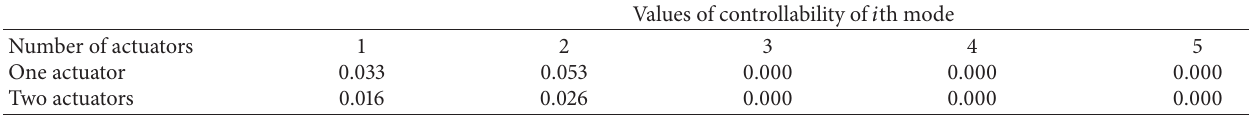
Figure 6: Frequency response of the plate controlled by the piezoelectric actuator-sensor. The first three modes are the controlled modes, while the next two modes are the residual modes: (a) one actuator-sensor and (b) two actuator-sensors. Table 10: The effect of values of controllability for optimal location, whenever the first two modes are controlled.